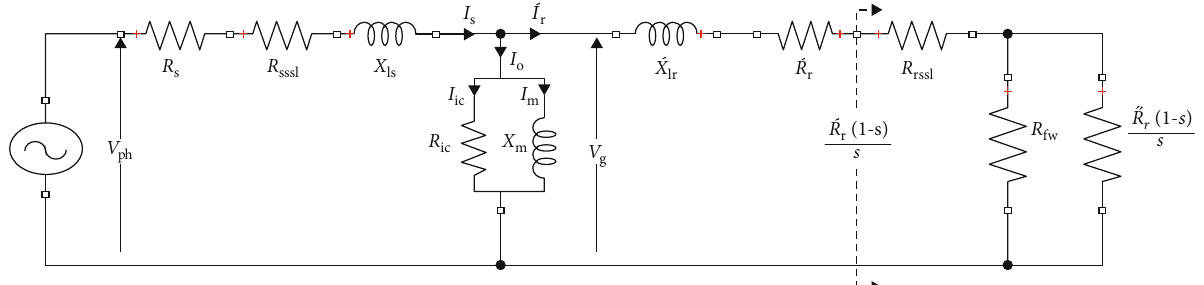
Figure 1: Proposed steady-state equivalent circuit of induction motor per